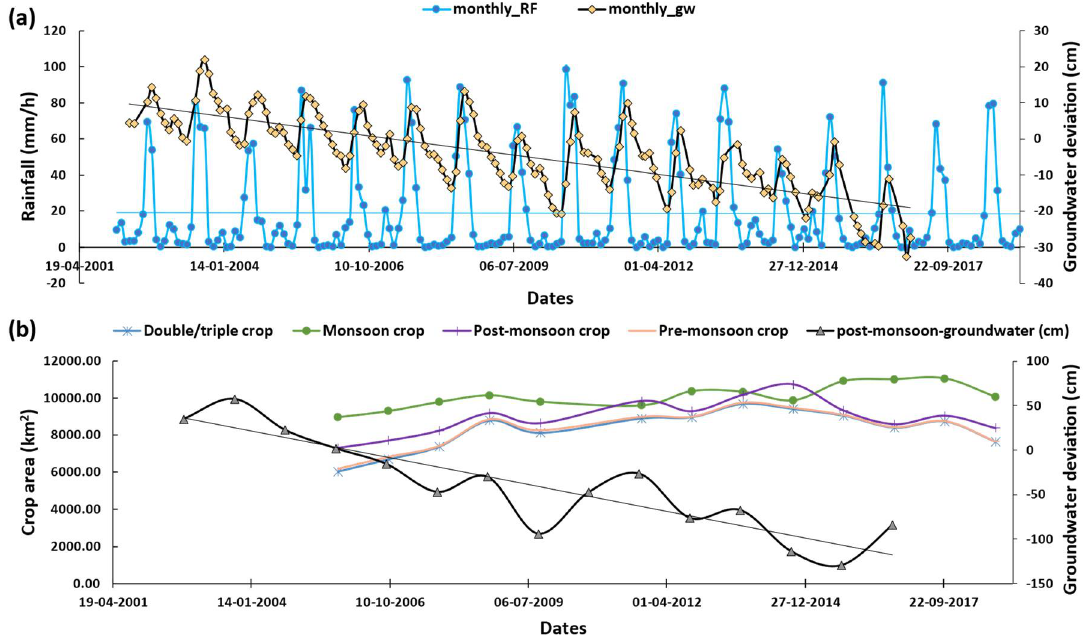
Figure 6. ( a ) Catchment-scale monthly trends of groundwater (GW) and rainfall (RF). The lag between RF and GW is evident. Groundwater values are GRACE-derived and represent the monthly deviation of groundwater from a 2004–2010 time-mean baseline. The overall rainfall trends have not changed much. ( b ) Crop areas and post-monsoon groundwater deviation trends at annual scale. Crop areas are steadily rising whereas groundwater is sharply declining over the years.